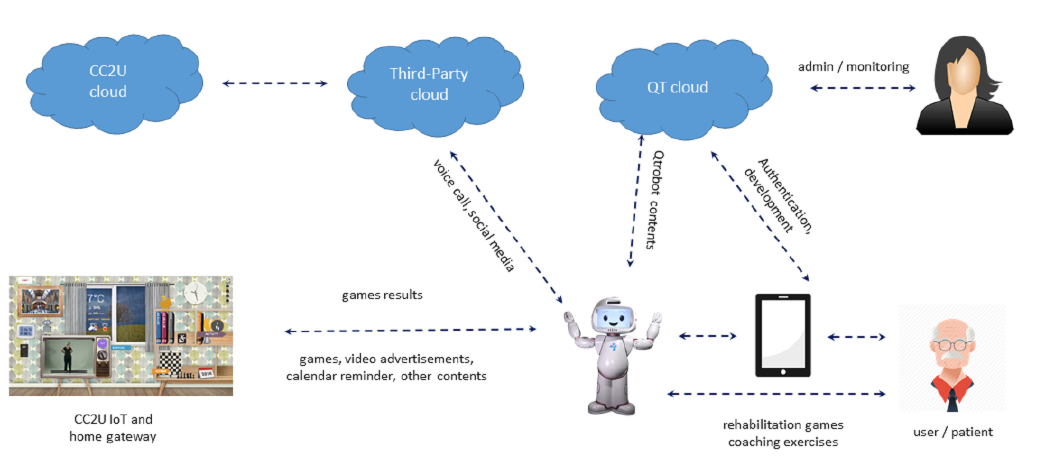
Figure 2. Data flow in SAR scenarios